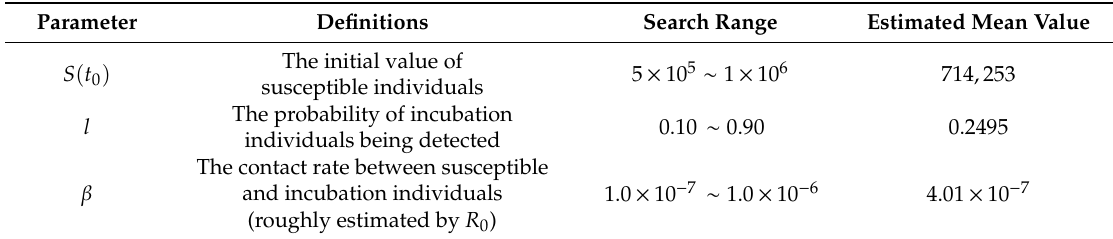
Table 1. SEIR_QJD parameter setting